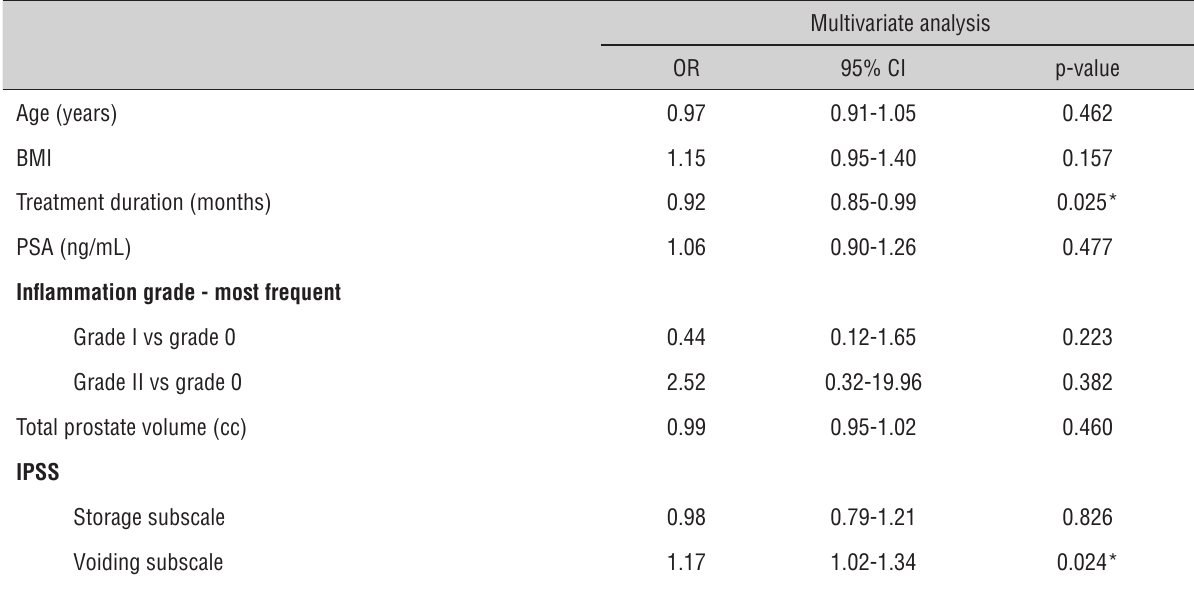
Table 6 - Predictive factors of symptomatic improvement after alpha blocker therapy on multivariate analysis.